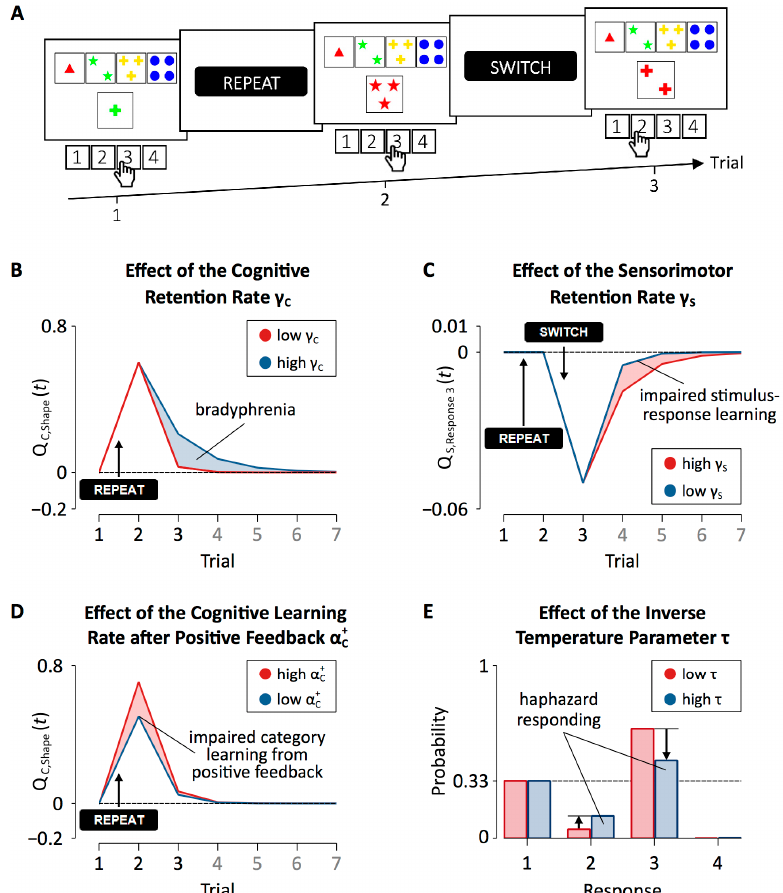
Figure 7. Exemplary effects of between-group variations of latent variables of the parallel RL model. ( A ) A showcase trial sequence on the cWCST as presented in Figure 1. ( B ) Feedback predictions for the application of the shape category across seven trials (panel A shows the first three of them). A positive feedback followed the application of the shape category on Trial 1, which increased feedback predictions for the shape category. With high values of cognitive retention rates (i.e., γ c ), such as seen in patients with Parkinson’s disease (PD) and patients with amyotrophic lateral sclerosis (ALS), feedback predictions for categories remain at high levels when transferring to the next trial. ( C ) Feedback predictions for the execution of response 3. The execution of response 3 produced a positive feedback on